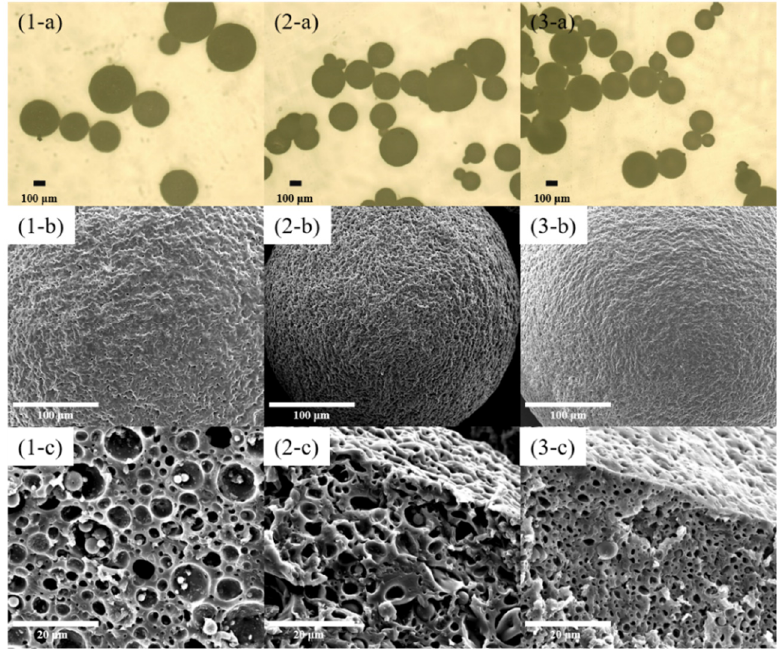
Figure 2. Optical images ( a ), SEM image ( b ), and cross-sectional SEM image of ( 1-a , 1-b and 1-c ) P-M 1 . 5 A 1400 T 0 . 6 , ( 2-a , 2-b and 2-c ) P-M 1 . 5 A 3000 T 0 . 6 , and ( 3-a , 3-b and 3-c ) P-M 1 . 5 A 6000 T 0 . 6 . Magnification is ×1000 ( b ) and ×5000 ( c ).